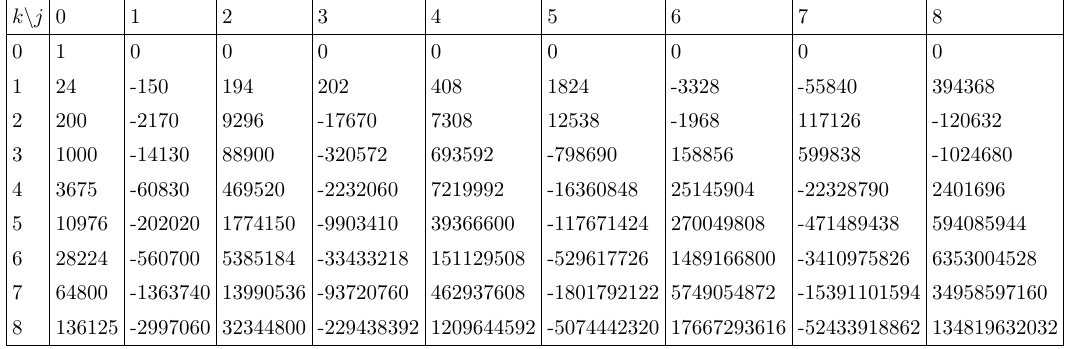
Table 29. Table of b jk coe(cid:14)cients for h SU(5)